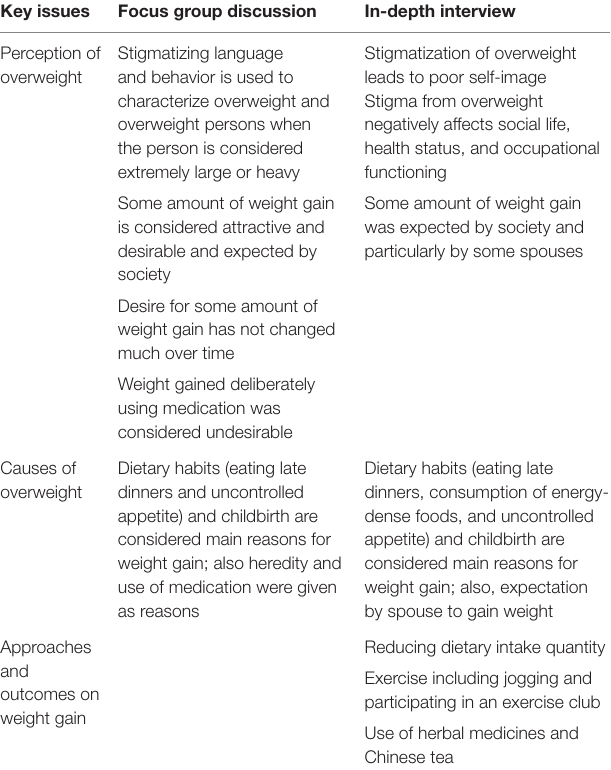
TaBle 1 | comparison of perceptions and beliefs across focus group discussion and in-depth interview